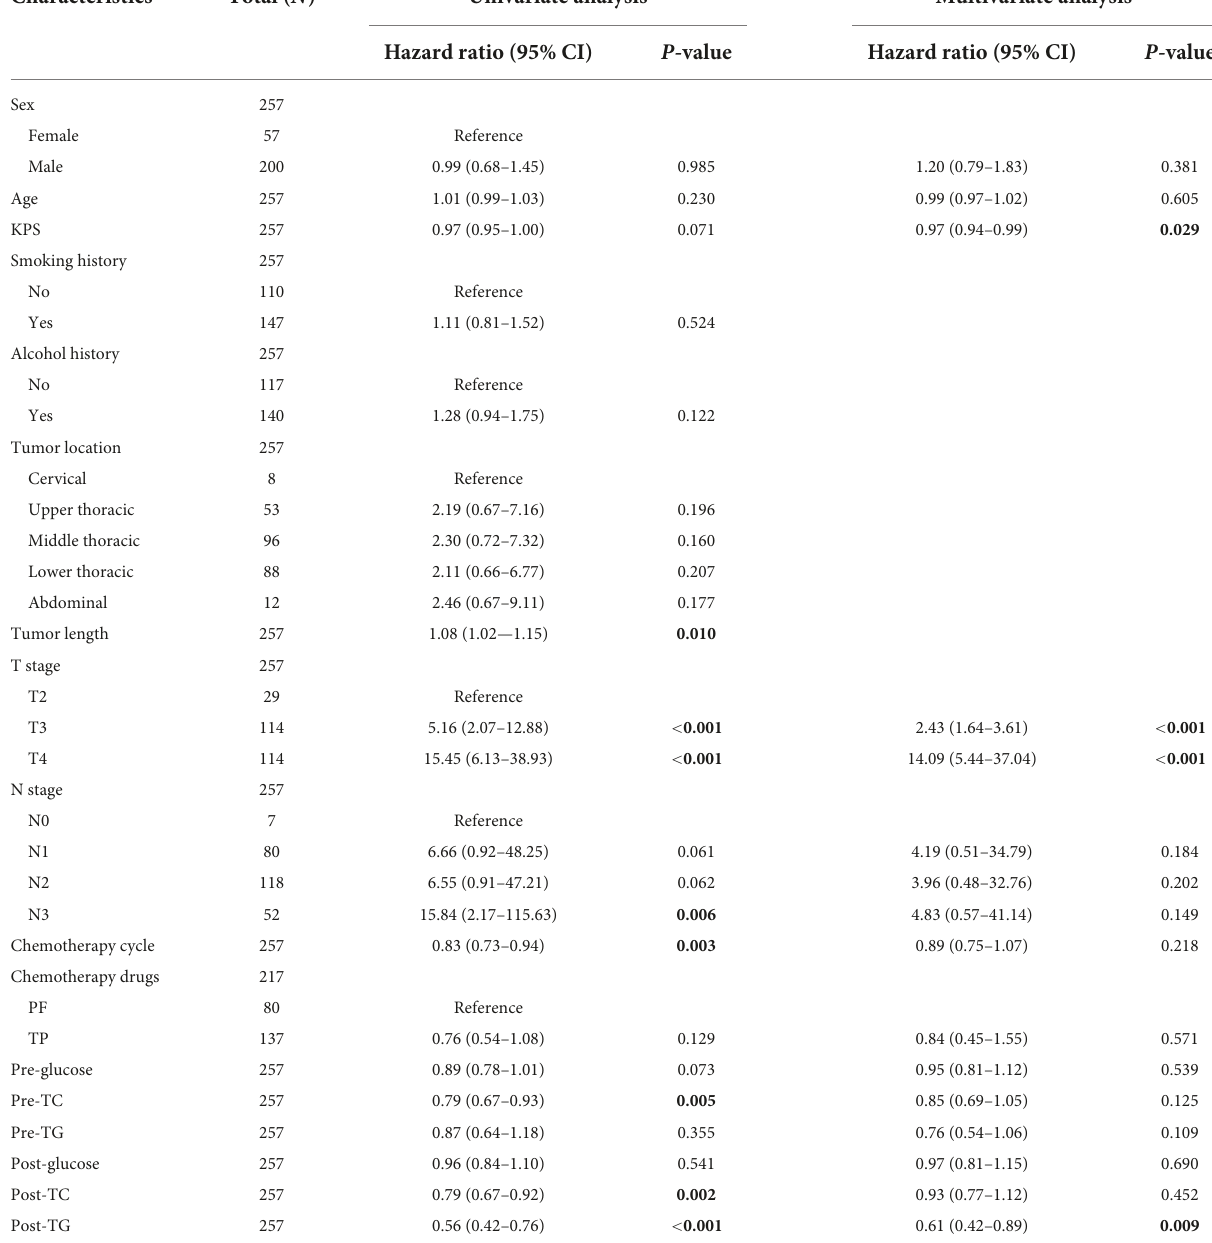
TABLE 2 Univariate and multivariate Cox regression analyses of factors associated with overall survival.